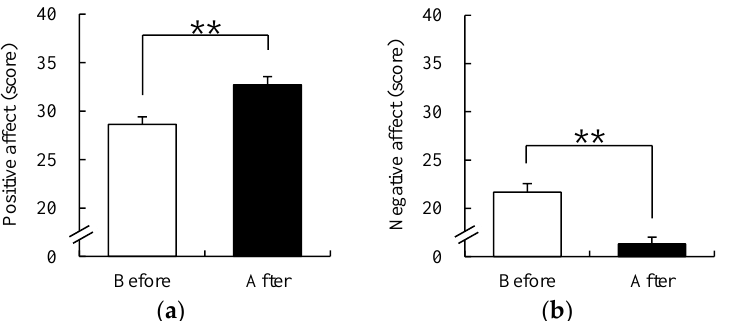
Figure 8. Changes in scores of positive affect and negative affect schedule (PANAS) before and after the FCA. ( a ) Positive affect of PANAS; ( b ) Negative affect of PANAS. Data are presented as mean ± standard error ( n = 61). Significance was verified by the Wilcoxon signed-rank test; ** p < 0.01.